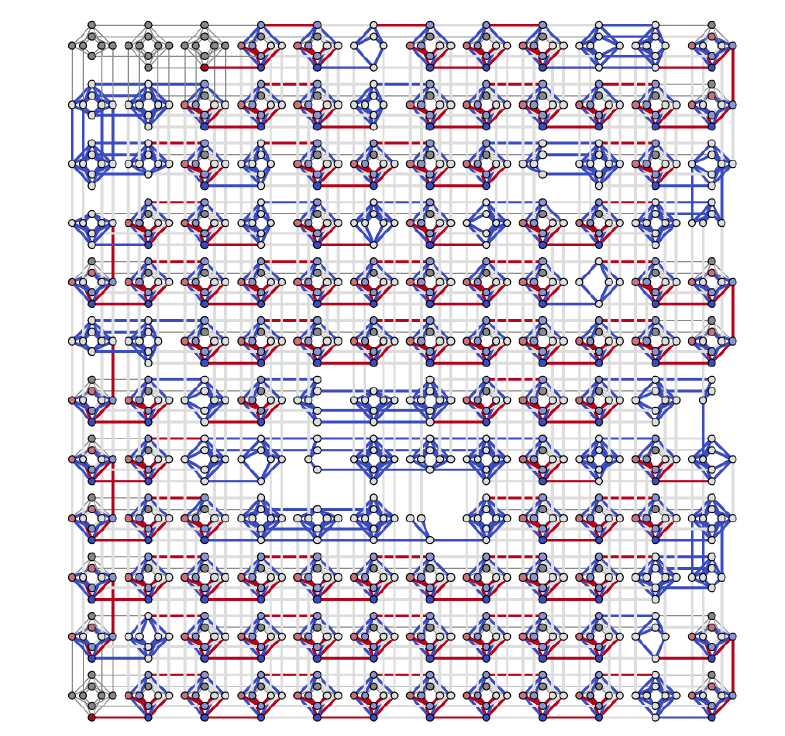
x i = − n + 2 (corresponding to QUBO constraint i = 1